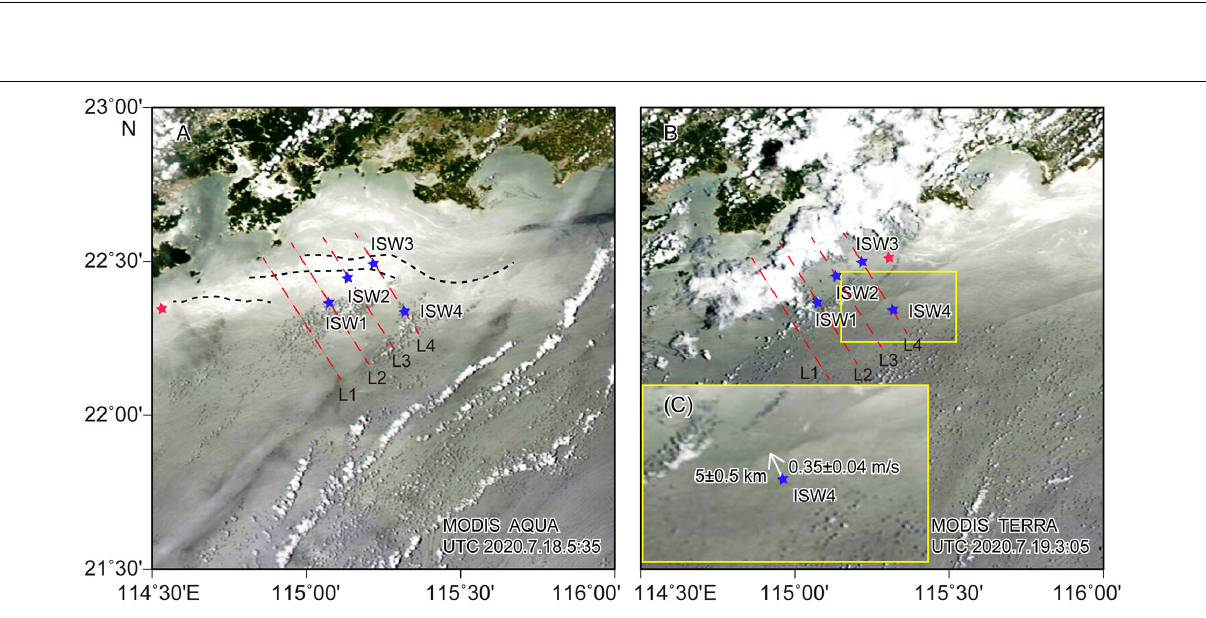
FIGURE 3 | Moderate Resolution Imaging Spectroradiometer images of the ISWs acquired by NASA Aqua (A) and Terra satellites (B) at 05:35 UTC on July 18, 2020 and 03:05 UTC on July 19, 2020. The yellow border illustration (C) is a partial enlargement of panel (B) . Red dashed lines are the acoustic backscatter survey lines of L1, L2, L3, and L4, and solid blue pentagrams show ISW positions identified from the backscatter images. The black dashed curves in panel (A) indicate the wave crest of ISWs with large displacement in the study area. Red solid pentagrams indicate the western boundary of the strong ISW dissipation zone, and the distance between the positions of these two pentagrams is approximately 82 km (eastward-moving velocity 1 m/s).